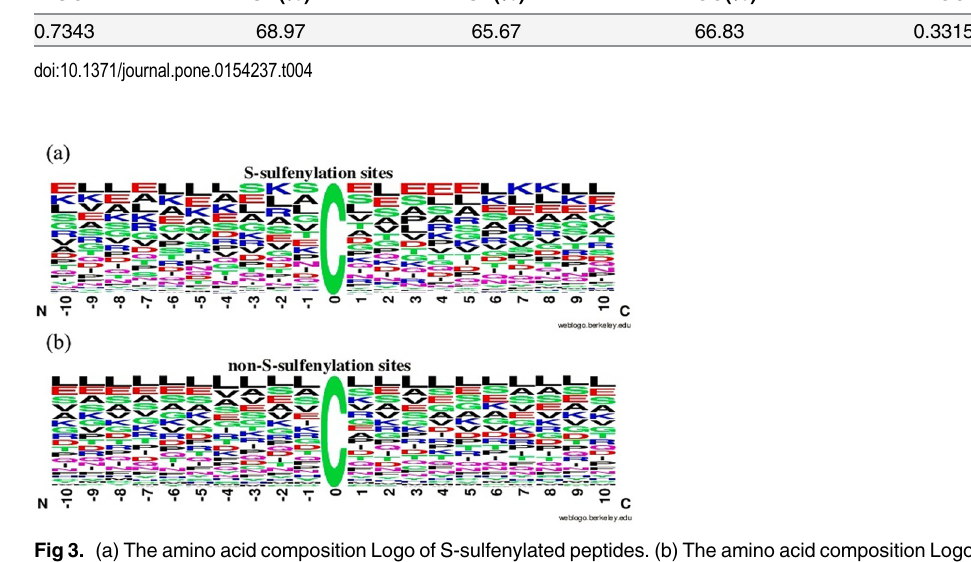
Fig 3. (a) The amino acid composition Logo of S-sulfenylated peptides. (b) The amino acid composition Logo of non-S-sulfenylated peptides.